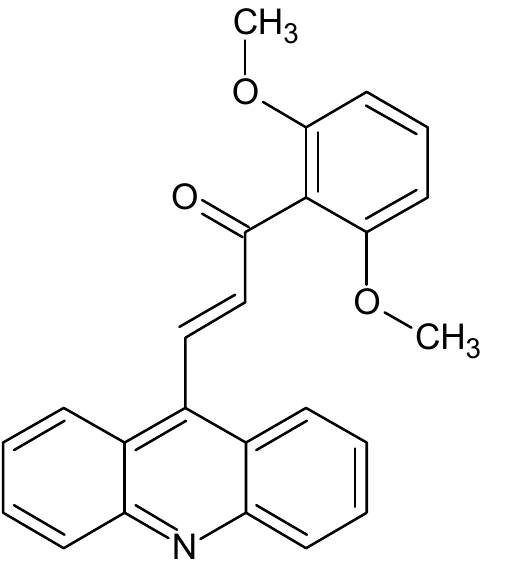
Figure 14. Chalcone 1C structure ((2E)-3-(acridin-9-yl)-1-(2,6-dimethoxyphenyl)prop-2-en-1-one). 4.2. Cell